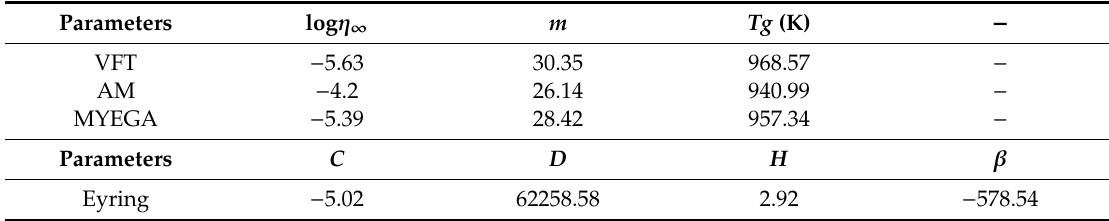
Figure 2. ( a ) Viscosity data of 7.9Cs 2 O-23.2CaO-66.7SiO 2 -1Fe 2 O 3 (the data in the red circle are for fitting); ( b ) results of the low-temperature extrapolation of the four models. Table 1. Obtained parameters of 7.9Cs 2 O-23.2CaO-66.7SiO 2 -1Fe 2 O 3 in the modified Eyring model.